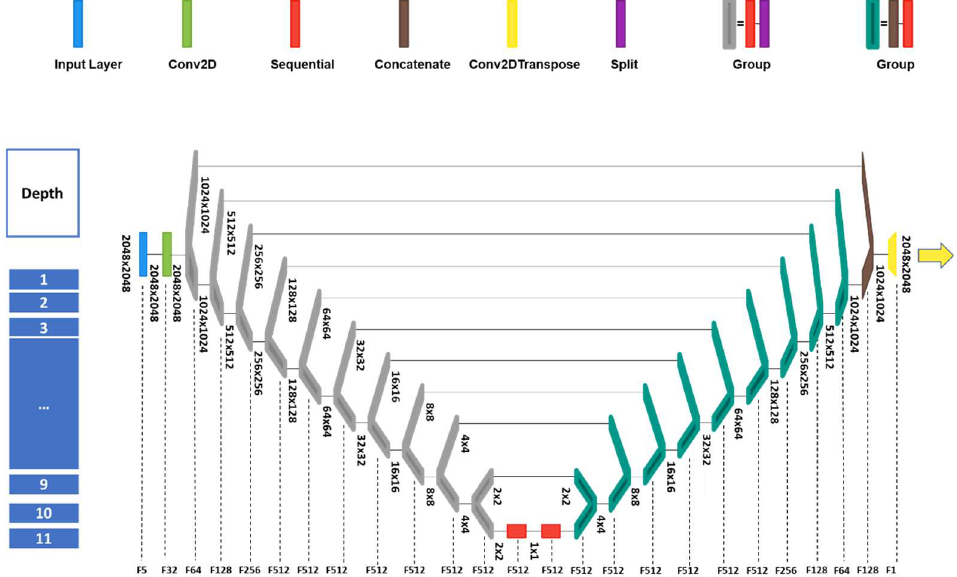
Figure 2. U-Net structure for energy distribution prediction via Net2Vis [22].